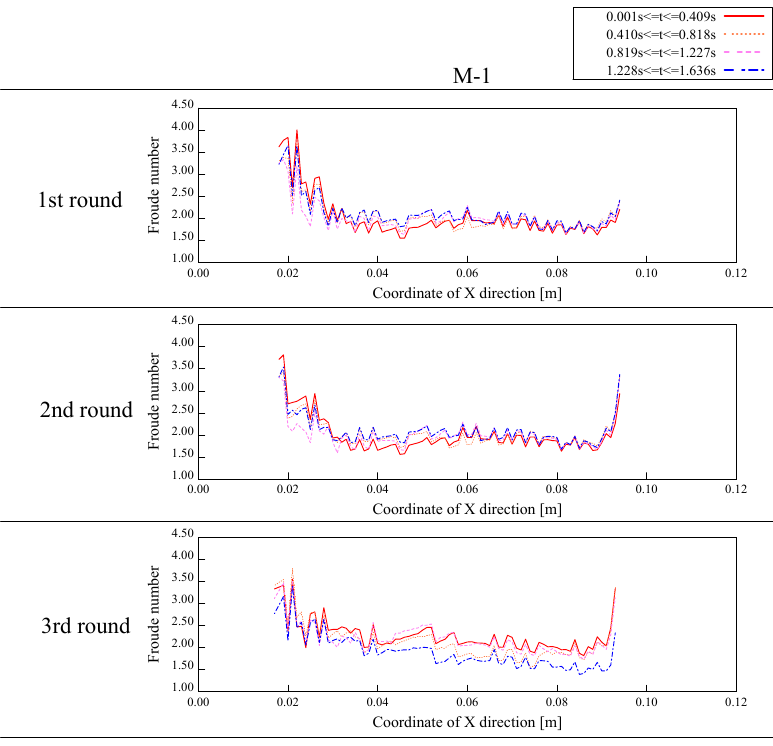
Figure 13. Relationship of Froude numbers in each cross section from H-1. Geosciences 2019 , 9 , x FOR PEER REVIEW